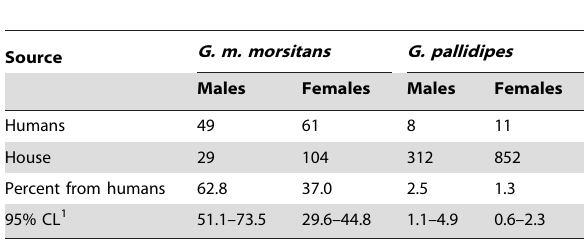
Table 2. Catches from humans in the house and from the house itself, in 95 days during Experiments